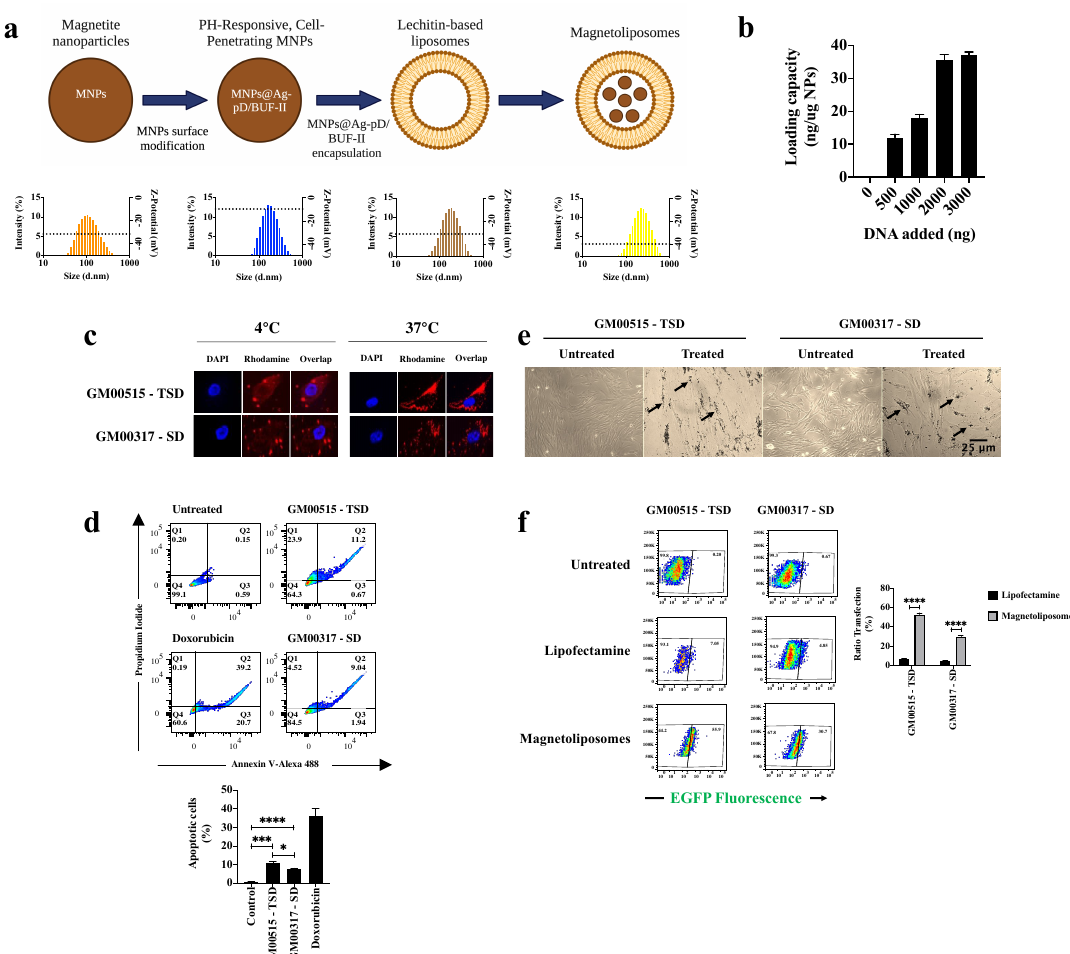
Figure 3. Cell viability and transfection ratio of MLPs on GM2 fibroblasts. ( a ) Upper panel shows the experimental strategy for MLPs synthesis, while the bottom one shows the hydrodynamic diameter and Z-potential (dotted line). ( b ) Loading DNA capacity. ( c ) MLP internalization assays. Note the intracellular accumulation of the Rho-labeled MLPs when the GM2 fibroblasts are incubated at 37 ◦ C, while their incubation at 4 ◦ C resulted in a peripheral distribution. ( d ) Apoptosis assays performed on GM2 fibroblasts. The upper panel shows a representative trace for each quadrant. Q2 quadrant was interpreted as late apoptotic cells. The lower panel shows the mean for three independent experiments. GM00515-TSD fibroblasts were more susceptible to interaction with MLPs than GM00317-SD fibroblasts. ( e ) Light microscopy of GM2 fibroblasts after their incubation with MLPs. Black arrows point to MNPs@Ag-pD/BUF-II nanobioconjugates. ( f ) Ratio transfection assays. A representative cytogram is shown in the left panel, while the mean of three experiments is presented in the right one. * p ≤ 0.05, *** p ≤ 0.001, **** p ≤ 0.0001. Two-tailed Student’s t